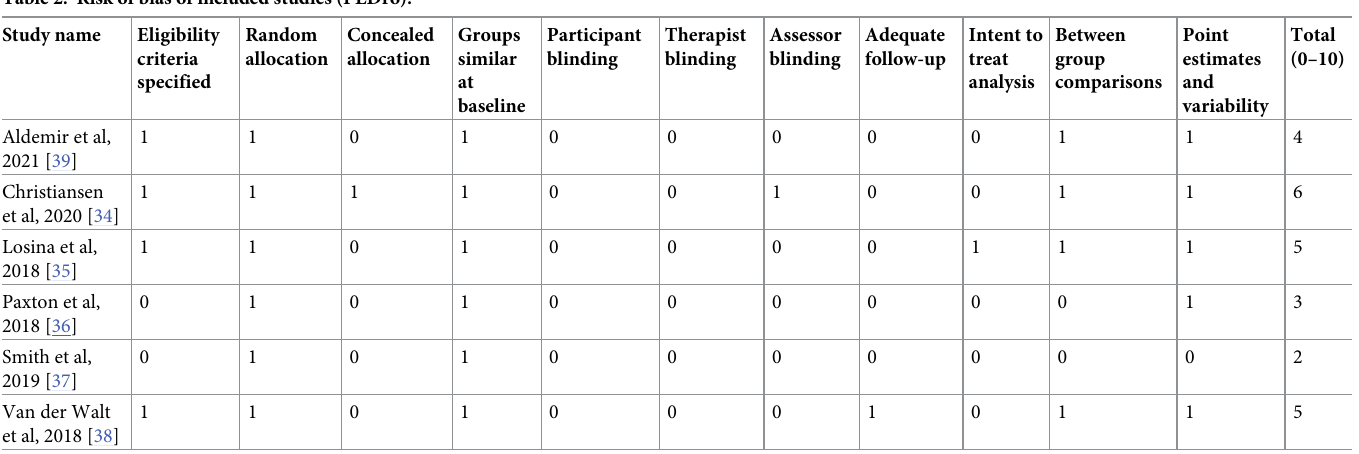
Table 2. Risk of bias of included studies